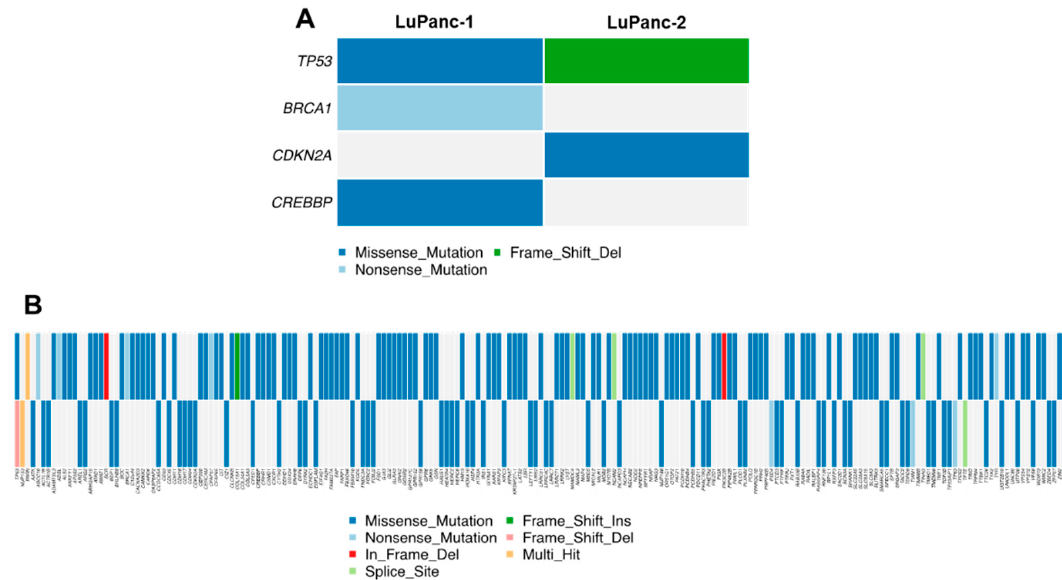
Figure 3. Mutational landscape of LuPanc-1 and LuPanc-2 cells based on WES. ( A ) Mutations in common oncogenes and tumor suppressor genes detected in both cell lines, according to Vogelstein and colleagues [32]. ( B ) Complete oncoplot of all mutations detected in both cell lines. For an enlargement of this oncoplot, see Figure S3.